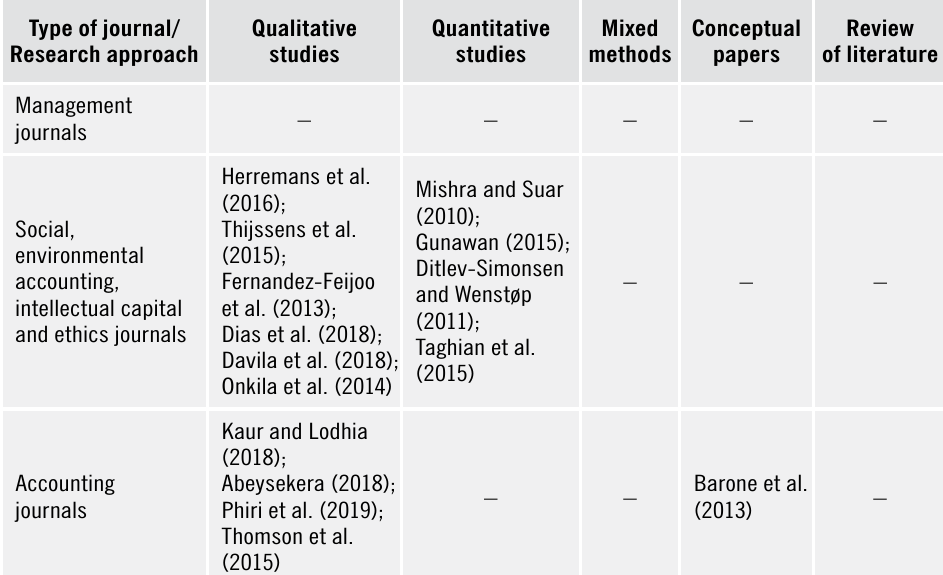
Table 4. Reviewed studies on the role of stakeholder groups in corporate social disclosures, by journal type and research approach